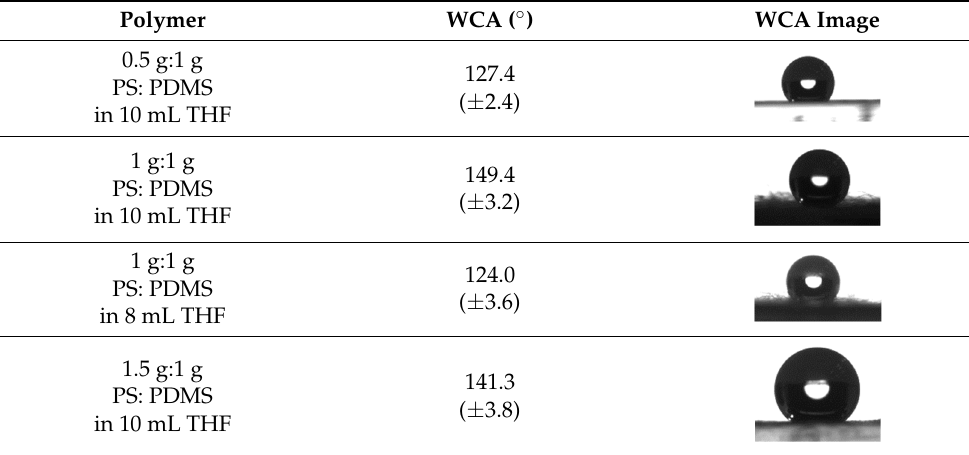
Figure 1. SEM images of: ( a ) neat PS 10%; PS/PDMS fiber mats produced on Al: ( b ) PS/PDMS/THF— 1:1:8 (g/g/mL), ( c ) PS/PDMS/THF—1:1:10 (g/g/mL), ( d ) PS/PDMS—0.5:1:10 (g/g/mL), and ( e ) PS/PDMS—1.5:1:10 (g/g/mL). The scale bar is equal to 30 µm.